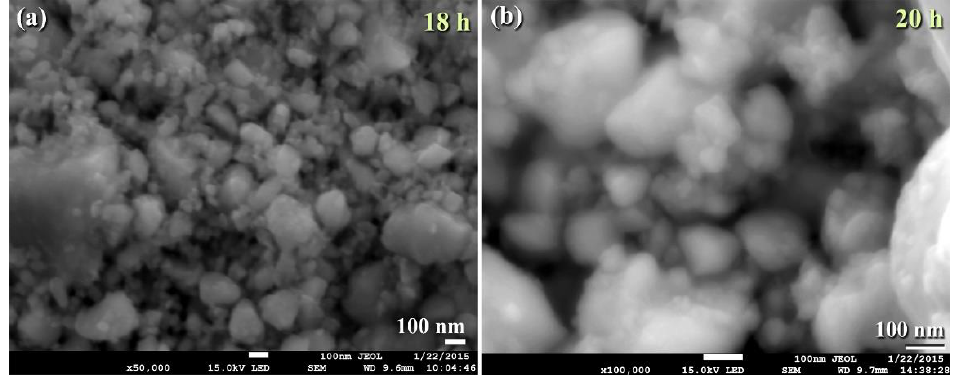
Figure 13. Micrographs FE-SEM ball milled WC powders after ( a ) 18, and ( b ) 20 h.